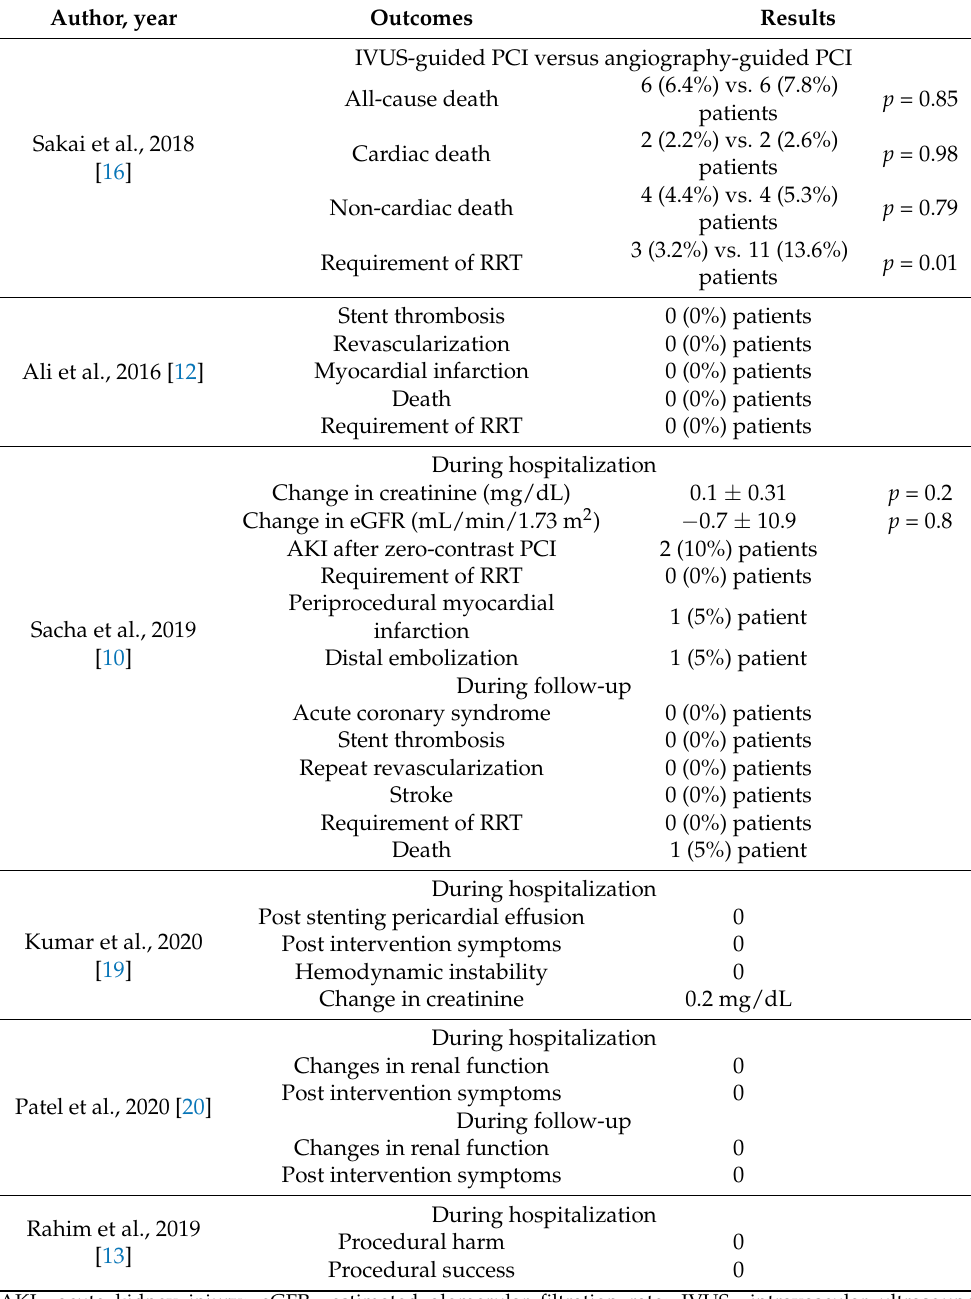
Table 3. Results reported in studies included in the systematic